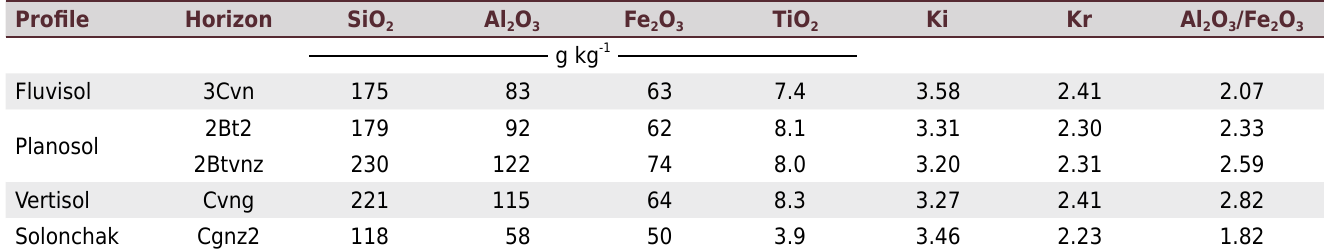
Table 5. Pedogenetic oxides, Ki, Kr, and Al 2 O 3 /Fe 2 O 3 ratio of some horizons in the soil profiles localized in lower course of the Acaraú River (Ceará State, Brazil) Profile